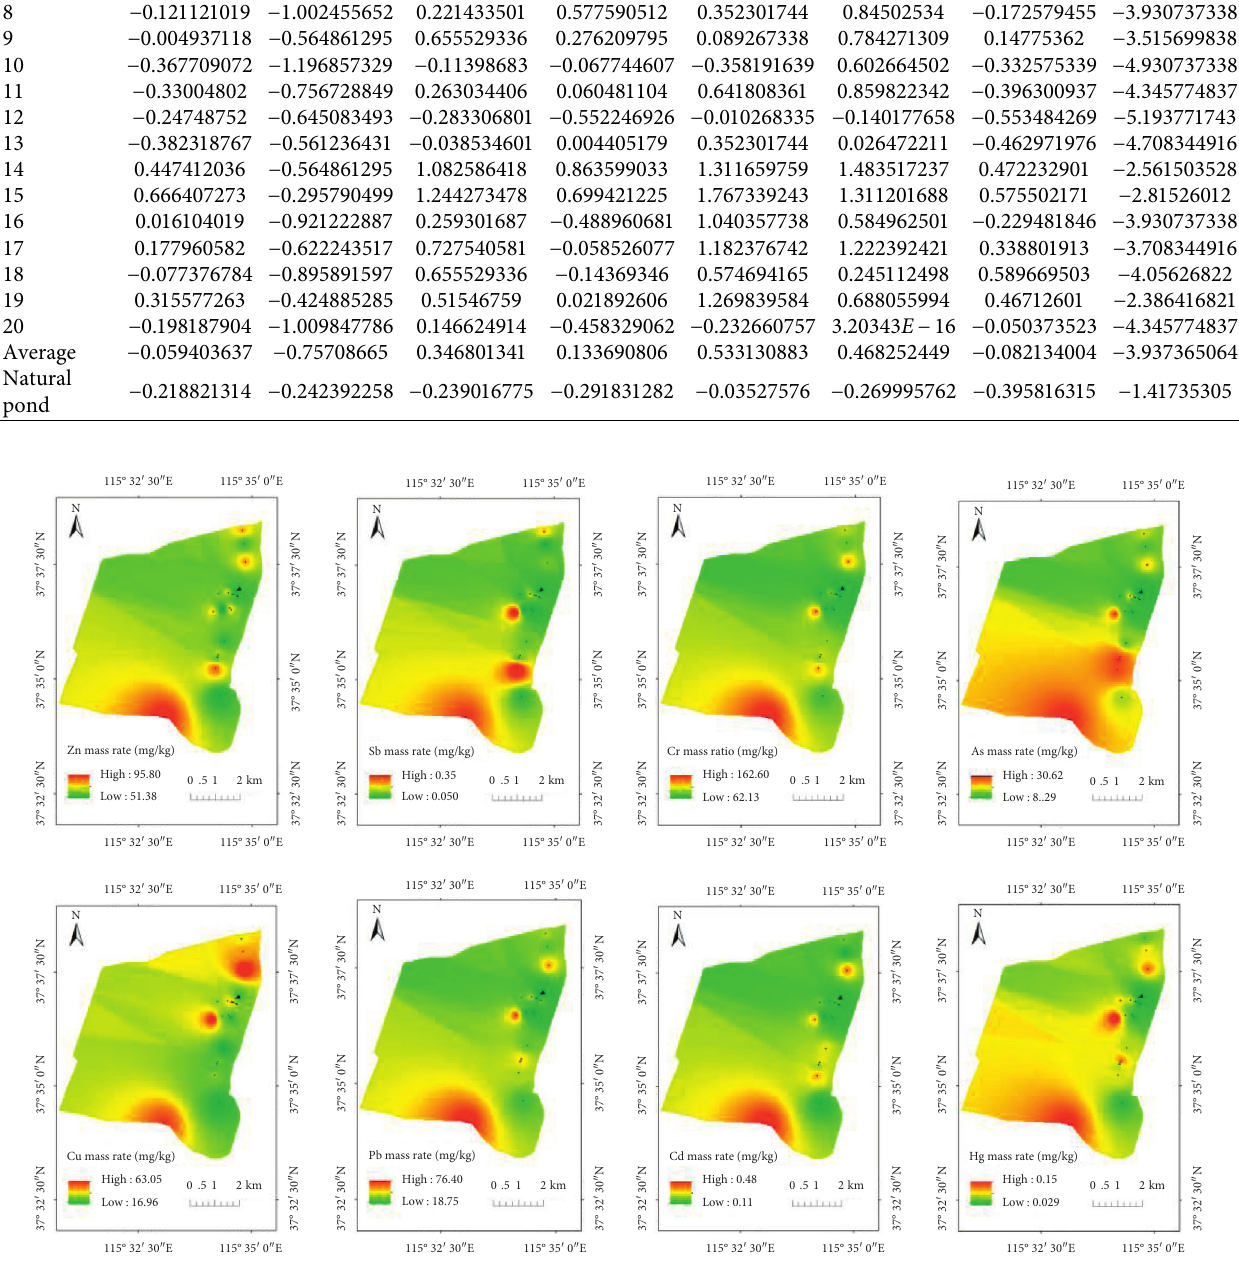
Figure 1: Spatial distribution of contents of 8 kinds of heavy metal elements in sediment at 0–50cm depth in the West Lake of Hengshui